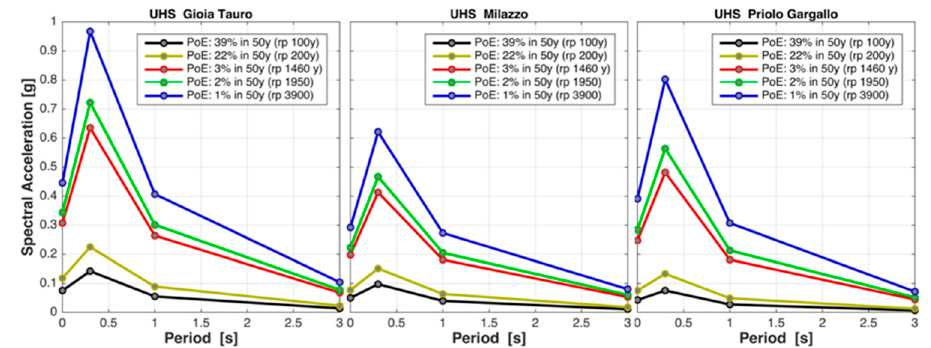
Figure 27. Uniform Hazard Spectra (UHS) for the three sites of interest, obtained for different probabilities of exceedance. UHS amplitudes are for PGA, and spectral acceleration at 0.3, 1, and 3 s.